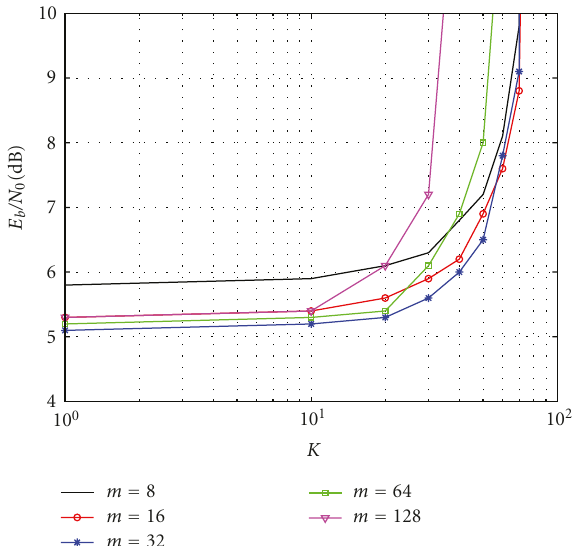
Figure 10: SNR required for a convolutionally coded FHSS system to achieve P b = 10 − 4 over Rician fading with κ = 10 dB versus the number of users K with an OPE receiver for SIR = 5dB and m =